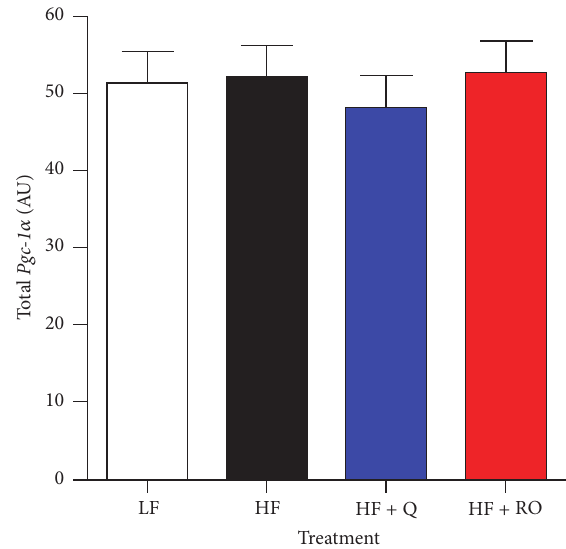
Figure 1: Pgc-1 𝛼 mRNA was measured by qRT-PCR in skeletal muscle samples of mice fed a low fat (LF), high fat (HF), high fat plus quercetin (HF + Q), or high fat plus red onion extract (HF + RO) diet for 9 wks. Values are shown as means ± SEM in arbitrary units